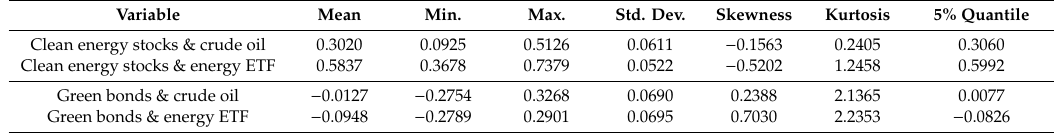
Table 2. Summary statistics of dynamic conditional